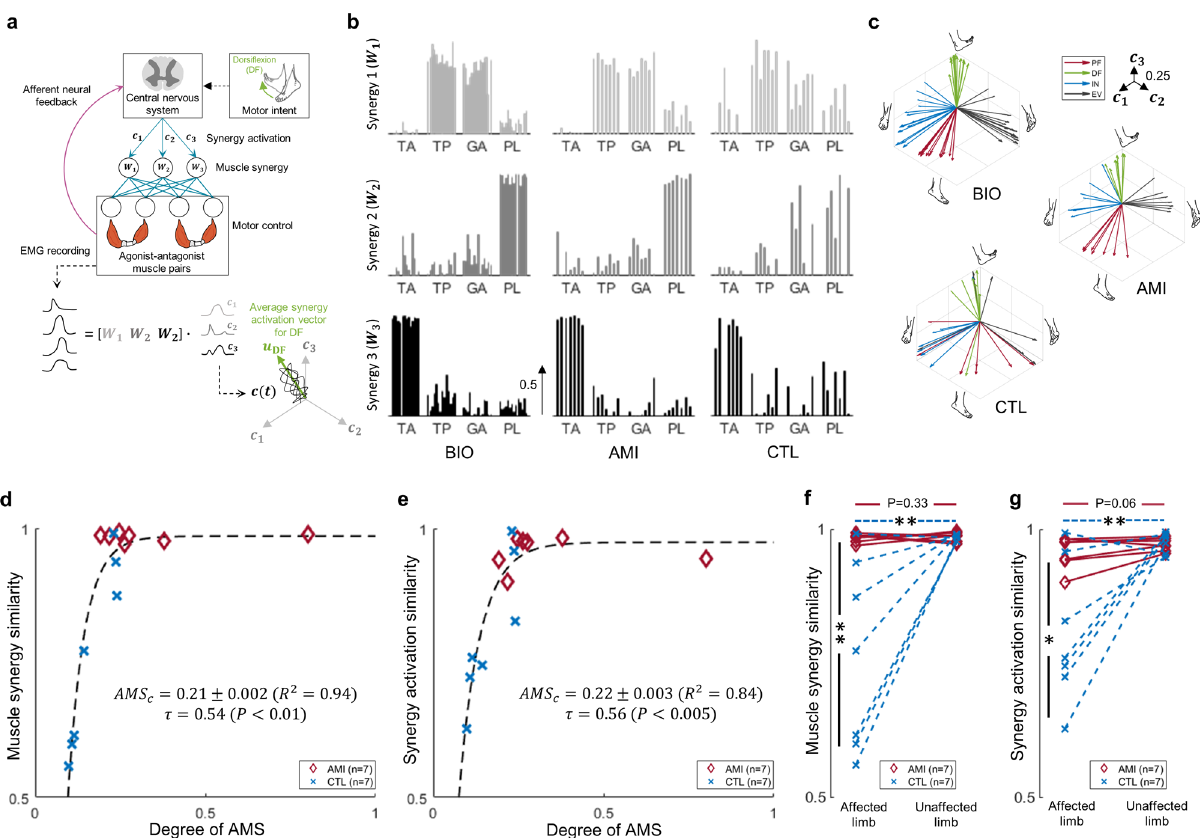
Fig. 2 Naturalness of motor control. In a , the framework of muscle synergies is shown. Varied motor control is executed by the activation of combinations of muscle synergies. In b , the extracted muscle synergies of all 28 limbs including the affected limbs of 14 subjects who had undergone either an Agonist- antagonist Myoneural Interface (AMI) amputation or a non-AMI amputation (CTL), and their unaffected limbs (BIO) are shown (BIO: n = 14, AMI: n = 7, CTL: n = 7). The muscle synergies were extracted from motor outputs of 4 muscles: the tibialis anterior (TA), tibialis posterior (TP), lateral gastrocnemius (GA), and peroneus longus (PL). In c , the average vectors of synergy activation pro fi les are shown. These vectors were derived from the muscle synergies found during discrete motion testing of all 28 limbs (BIO: n = 14, AMI: n = 7, CTL: n = 7). Each axis ( c 1 - c 3 ) indicates the activation of a muscle synergy ( W 1 - W 3 ). Here, the four different colors indicate the movements of plantar fl exion (PF, red), dorsi fl exion (DF, green), inversion (IN, blue), and eversion (EV, black). In d and e , the relationships between muscle synergy similarity and synergy activation similarity are shown with the degree of agonist-antagonist muscle strain (AMS) in a combined analysis of affected AMI and CTL limbs ( n = 14). Reported are the Kendall ’ s tau ( τ ), P , R 2 , the Jackknife mean, and s.d. for a critical degree of AMS ( AMS c ). In f and g , comparisons are shown of individual and interactive effects (AMI:CTL × affected:unaffected limb) for muscle synergy similarity and synergy activation similarity for all 28 limbs (BIO: n = 14, AMI: n = 7, CTL: n = 7). Here paired one-tailed t -tests were used for BIO-A:AMI and BIO-C:CTL comparisons, unpaired two-tailed t-tests were used for the AMI:CTL comparison, and 2-way ANOVA was used for the interaction analysis (* P < 0.05, ** P < 0.01). Where no signi fi cance is seen, a P value for the comparison is